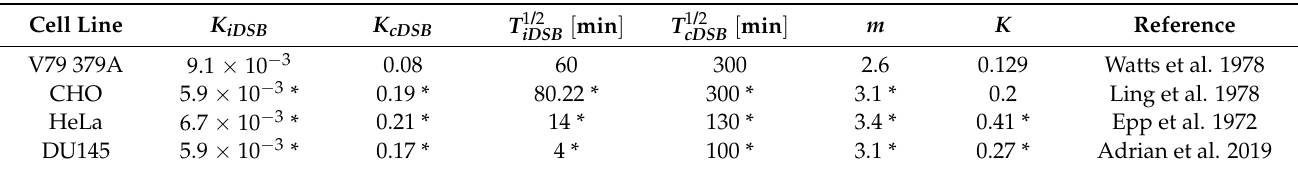
Table 1. Cell line dependent UNIVERSE parameters applied in this work. Values marked with a * have been adapted without modification from our previous publication